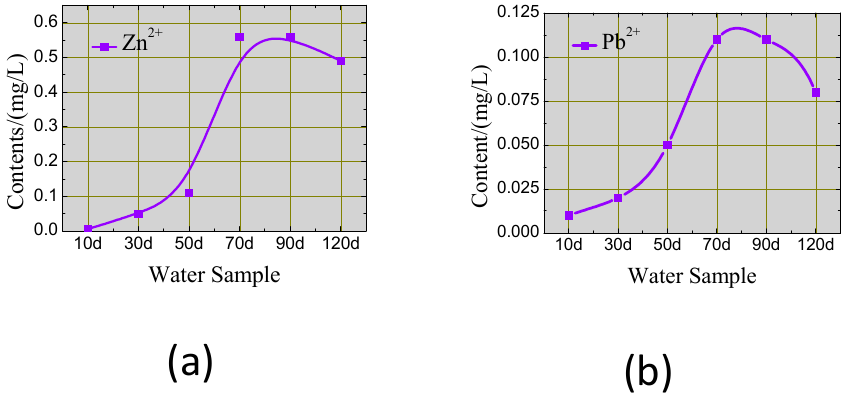
Figure 6. Dissolved ( a ) Zn 2+ and ( b ) Pb 2+ concentrations in the leachate.